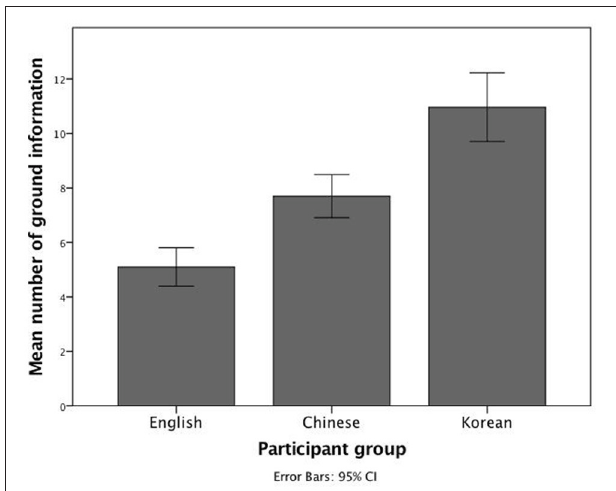
FIGURE 1 | Bar diagram showing the mean number of ground information mentioned by English, Chinese, and Korean participants in the picture description task. Korean participants reported the highest overall number of ground information, followed by Chinese participants, and English participants.